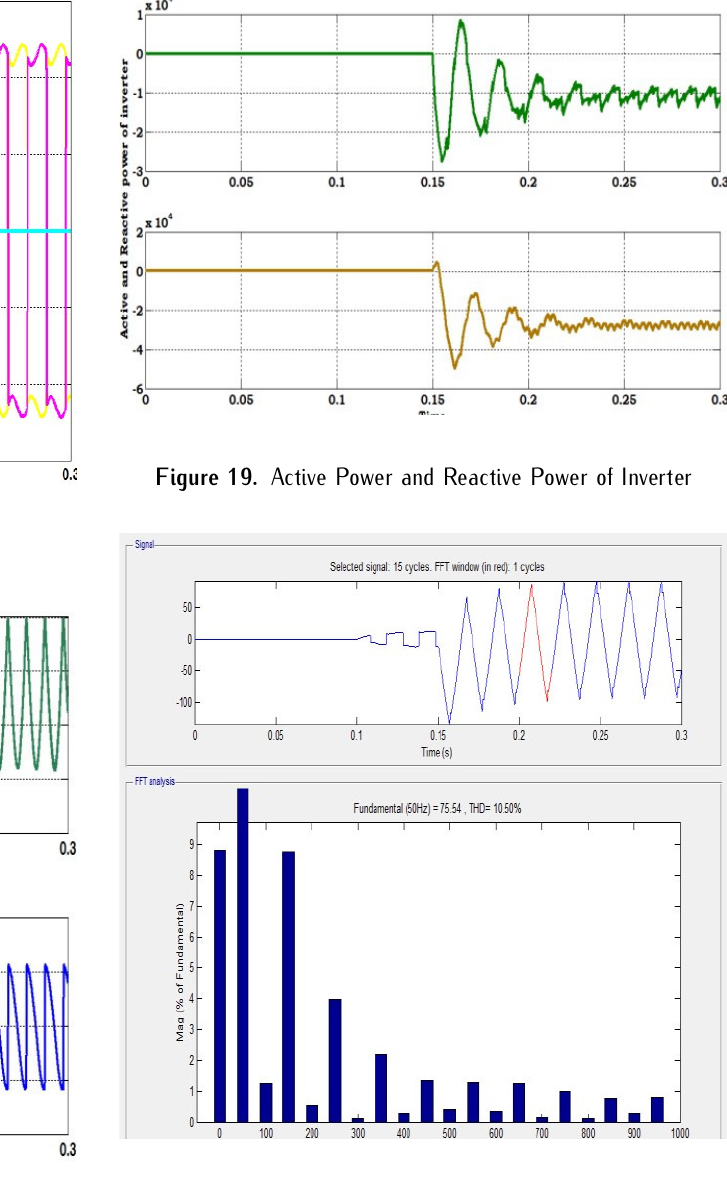
Figure 20. Waveforms of THD of Voltage at PCC Table 1. Comparison Table of the Proposed System with PI